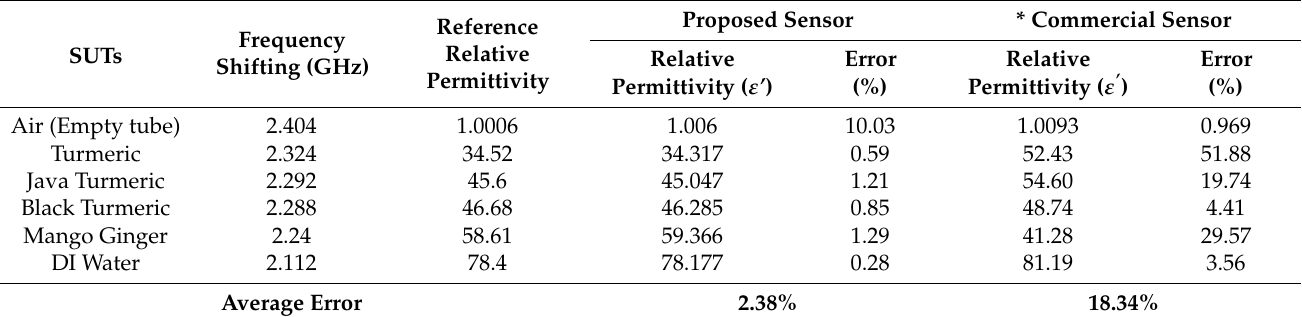
Table 7. Comparison of real permittivity and percentage error detection between the proposed and commercial sensors of several semi-solid